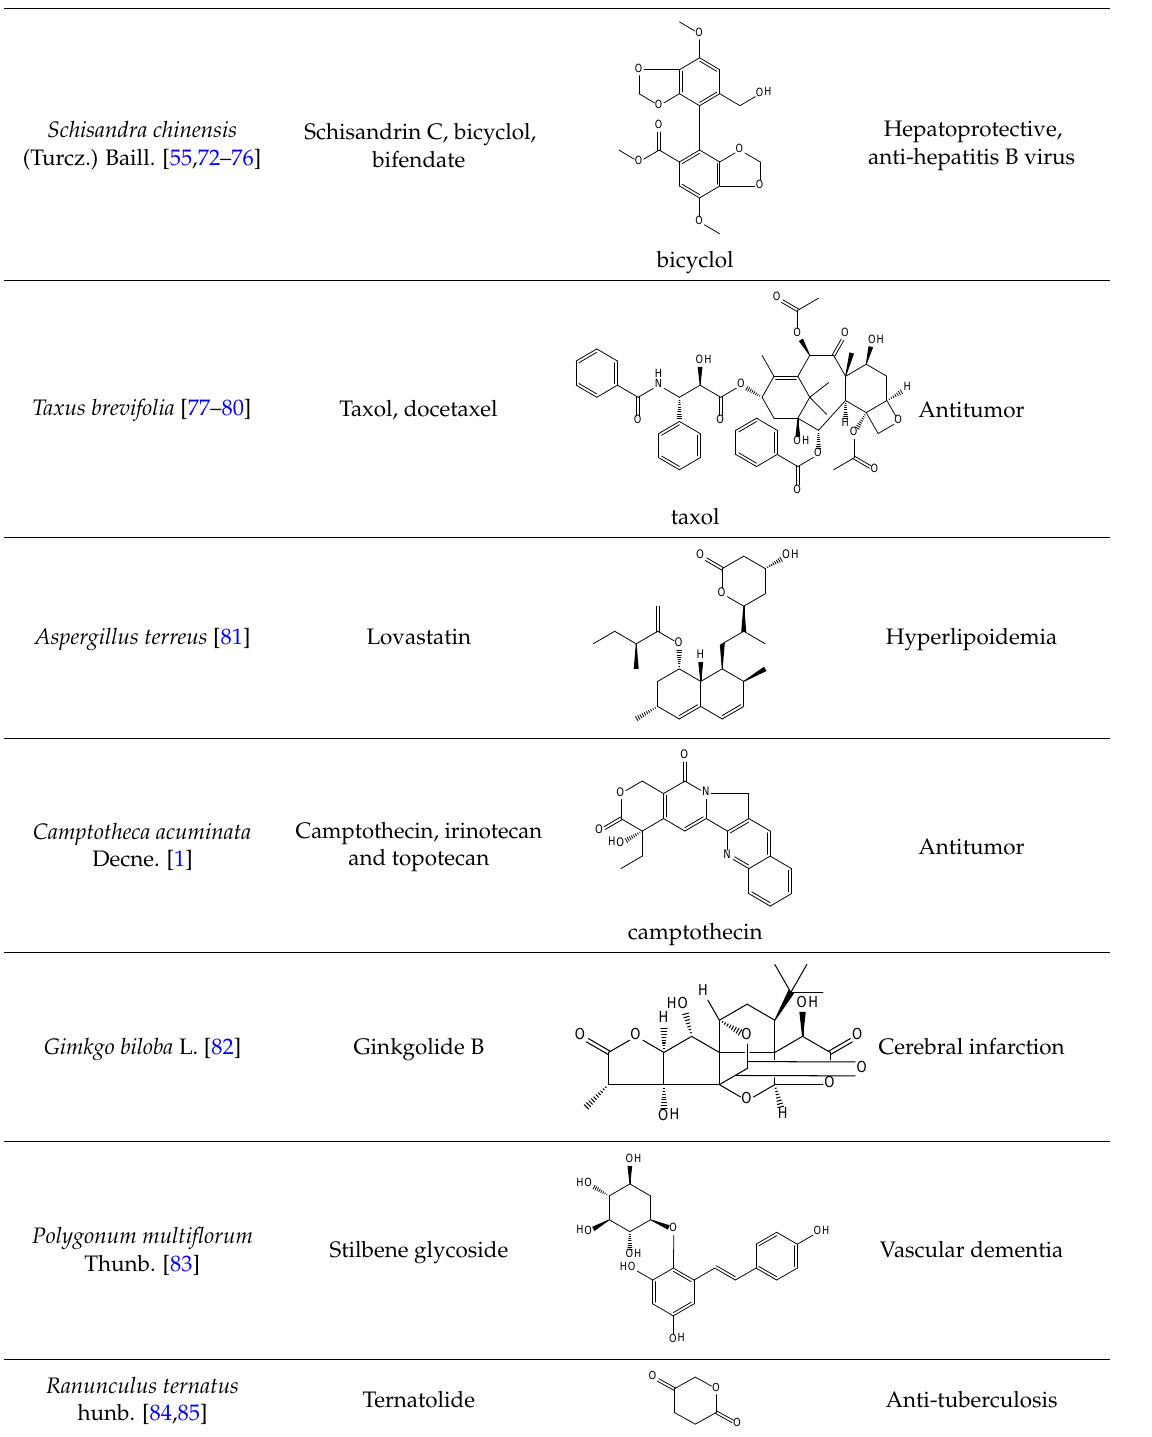
Table 3. Some drugs or compounds isolated or developed from natural products. Origin (Plant, etc. )